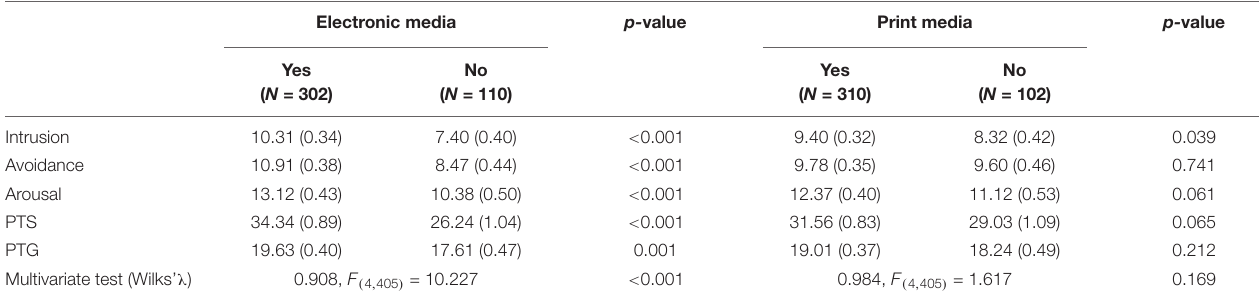
TABLE 5 | MANOVA table reporting the group difference based on indirect exposure to trauma in the form of news through electronic media and print media. Electronic media p-